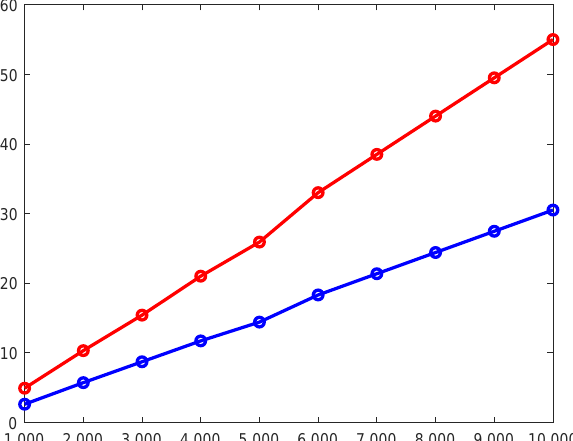
Figure 4. Runtime in seconds ( y -axis) for oversampling different numbers of objects in the minority class ( x -axis) by Fast-SMOTE (blue line) and NDO (red line).